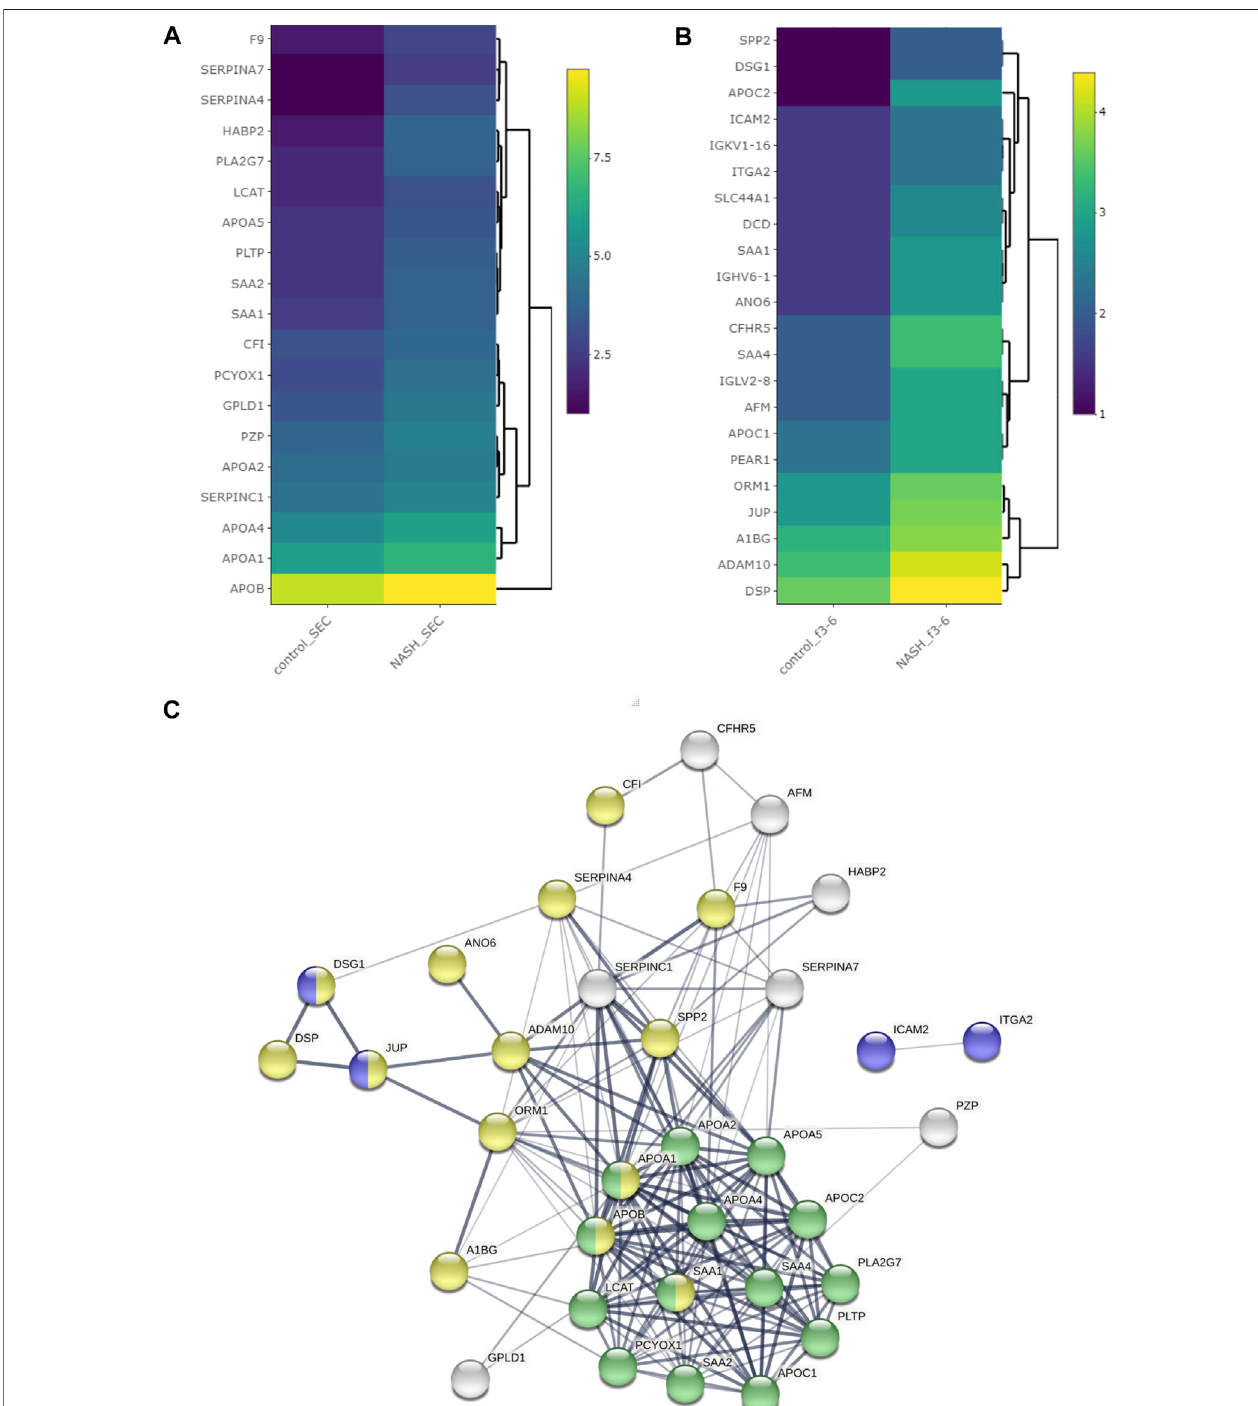
FIGURE 7 | Differentially expressed proteins among plasma EVs. Heatmap representing proteins with greater than 1.5-fold change in NASH plasma EVs, which wereisolated (A) bySECand (B) byDG. (C) Protein – protein interactionanalysiswasperformedbySTRINGsoftwareonsigni fi cantlyenriched proteinsinNASHEVs;the edgesindicate both functionaland physical protein associations; linethickness indicates the strength ofdata support; we used minimum required interaction score with medium con fi dence (0.400); disconnected nodes in the network were excluded; blue color represents cell adhesion proteins; green color represents plasma lipoprotein particle protein; yellow color represents vesicle-mediated transport; these proteins annotation was done by using Gene Ontology and UniProt.